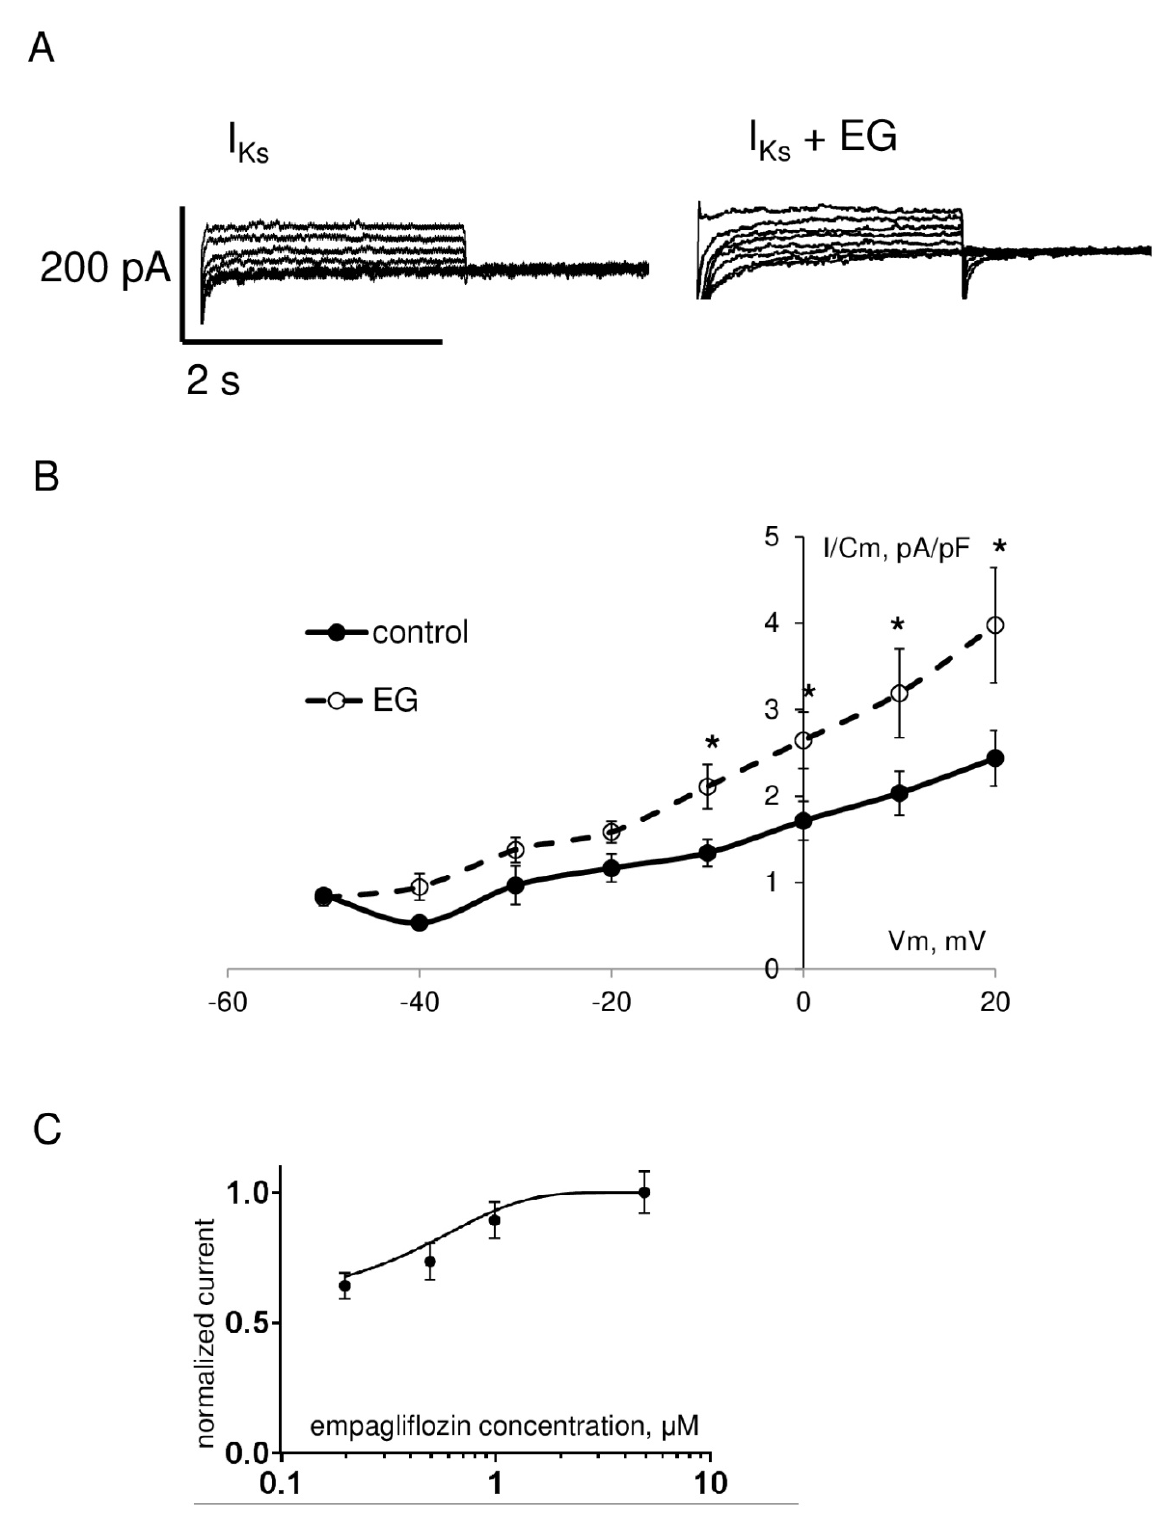
Figure 6. ( A ) Representative whole–cell current traces of I Ks in freshly isolated ventricular cardiomy- ocytes from zebrafish in control (left) and after 2 h incubation with 5 µ M empagliflozin (right). ( B ) The current density–voltage relationship of the I Ks in control ( n = 18) and in empagliflozin–treated ( n = 19) cardiomyocytes. * p < 0.05 obtained by Student’s t -test. ( C ) Concentration–response curve for empagliflozin effect on the I Ks current density at +20 mV. The solid line shows least–squares fit to the Hill